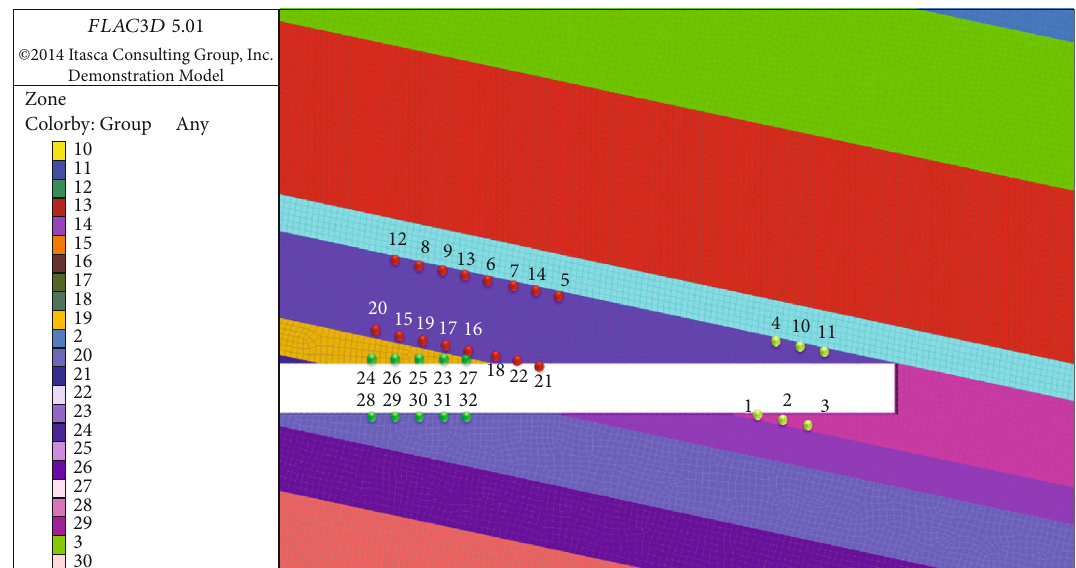
Figure 7: Schematic diagram of model monitoring